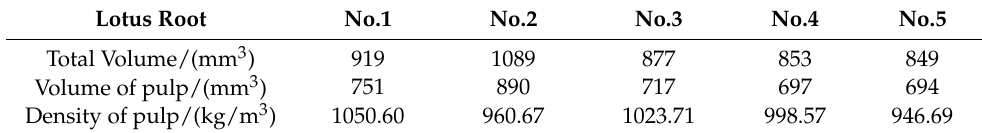
Figure 7. Images of a slice of the testing lotus root. ( a ) White pulp; ( b ) White stomata.